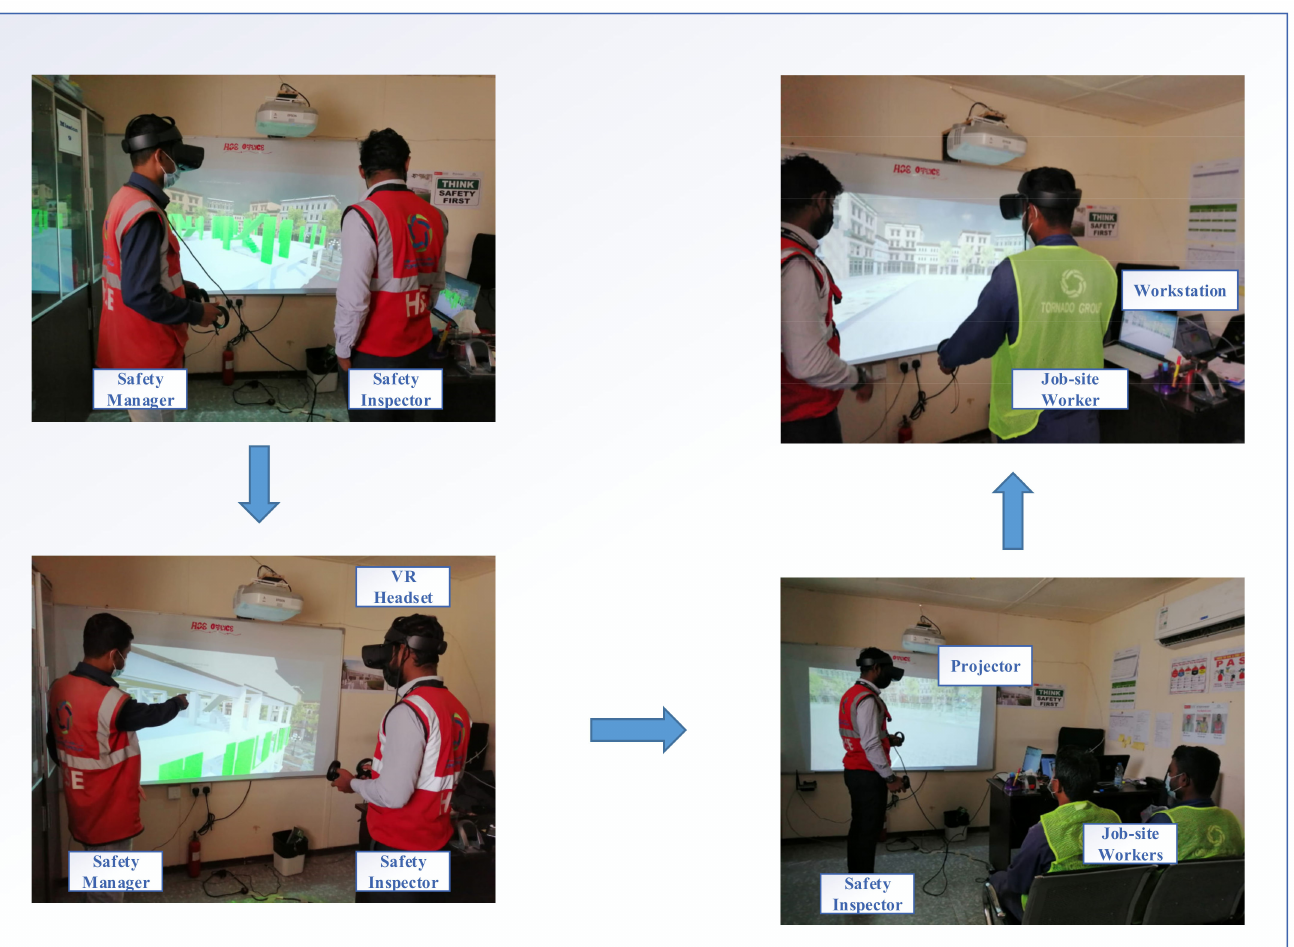
Figure 8. Knowledge exchange between